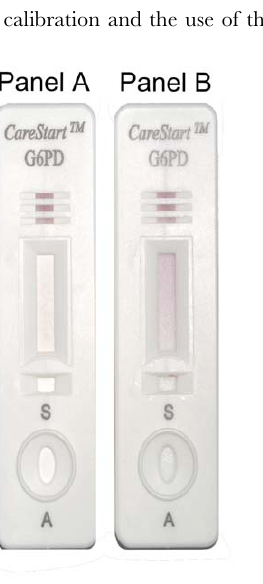
Figure 2. Design of the CareStart TM G6PD deficiency screening test and interpretation of the results. Panel A, no color change for sample with deficient G6PD enzymatic activity; Panel B, distinct purple color for sample with normal G6PD enzymatic activity.